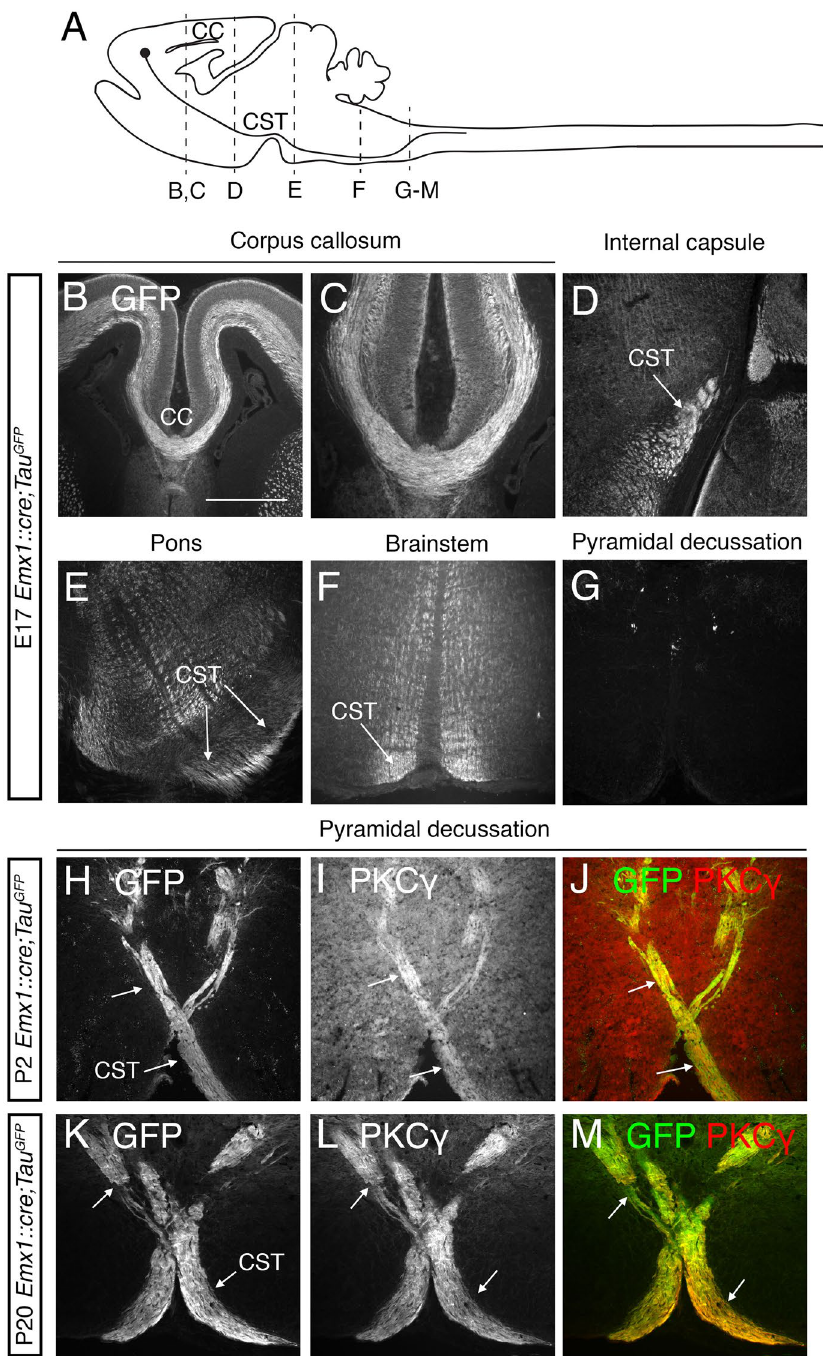
Figure 4. EMX1 is expressed in Corpus callosum and CST neurons before they cross the midline. ( A ) Schematic representation of a sagittal section through the CNS of a P2 mouse indicating the trajectory of the CST and the level of the coronal sections presented in this figure. Coronal sections of E17 (n = 3; B–G), P2 (n = 3; H–J) and P20 (n = 3; K–M ) Emx1 :: cre ; Tau GFP mice stained with anti-GFP ( B–M ) and anti-PKC γ , a marker of the CST ( H–M ). At E17, GFP was expressed in the corpus callosum axons at the midline ( B, C ). GFP staining was detected along the entire trajectory of the CST axons: in the internal capsule ( D ); at the level of the pons, where the CST adopts a ventral position ( E ); and in the brainstem, in a ventral position ( F ). At this age, the CST has not yet reached the pyramidal decussation ( G ). At P2 and P20, GFP staining co-located with PKC γ staining at the level of the pyramidal decussation ( H–M ). White arrows indicate CST axons. The scale bar represents 336 μ m in B and 168 μ m in (C-M)